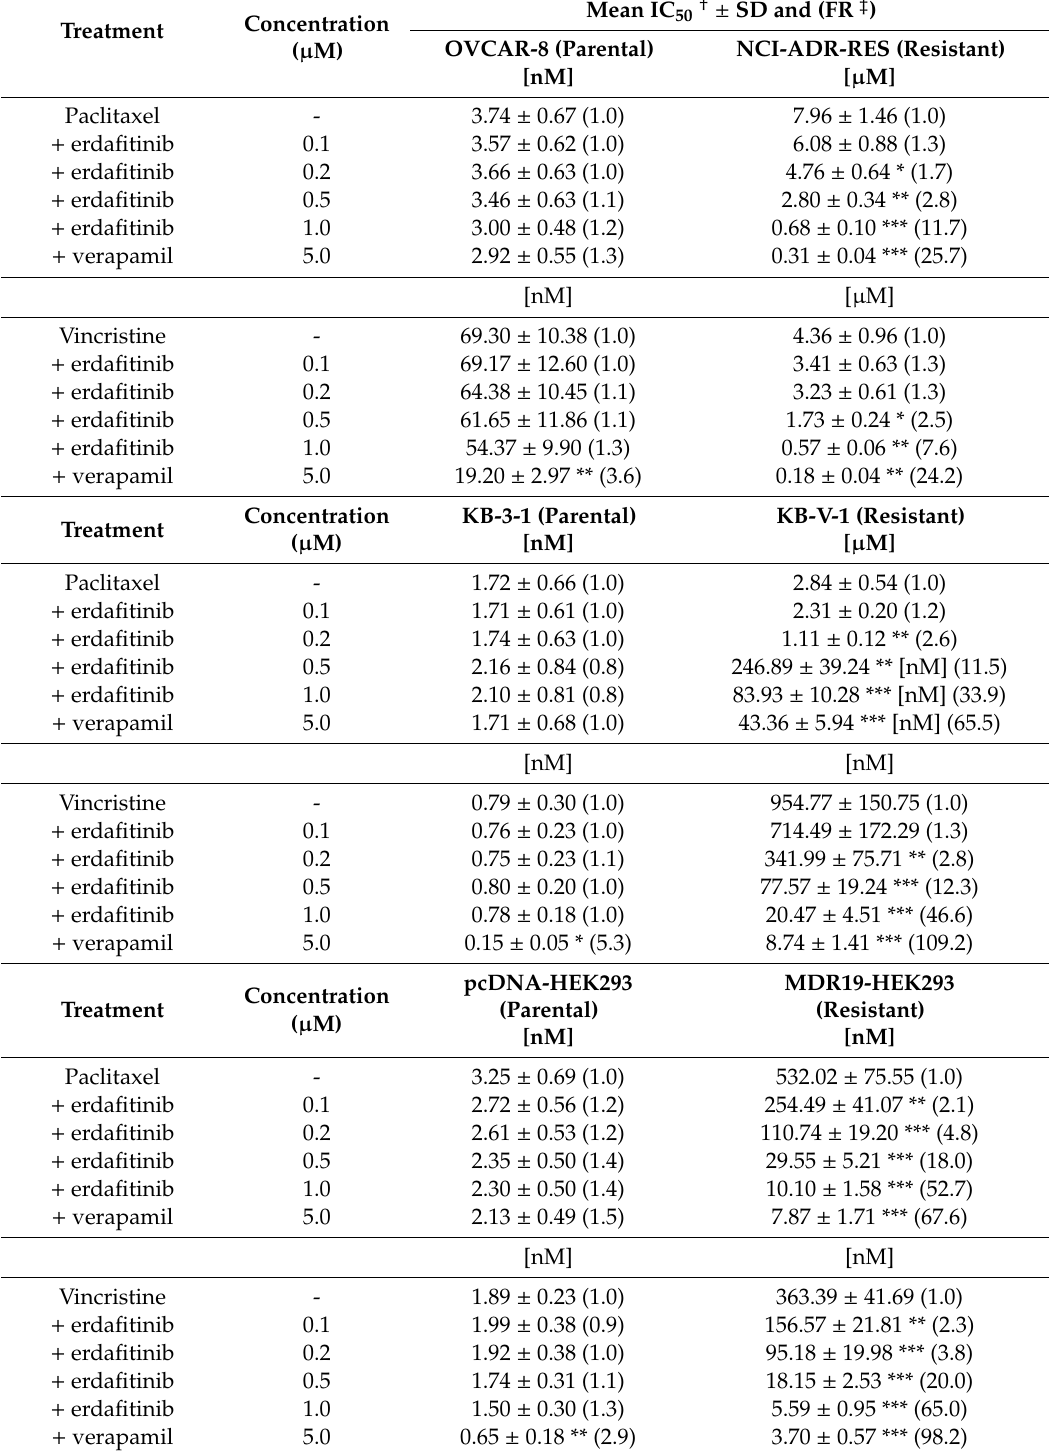
Table 2. The e ff ect of erdafitinib on ABCB1-mediated multidrug resistance in ABCB1-overexpressing human cell